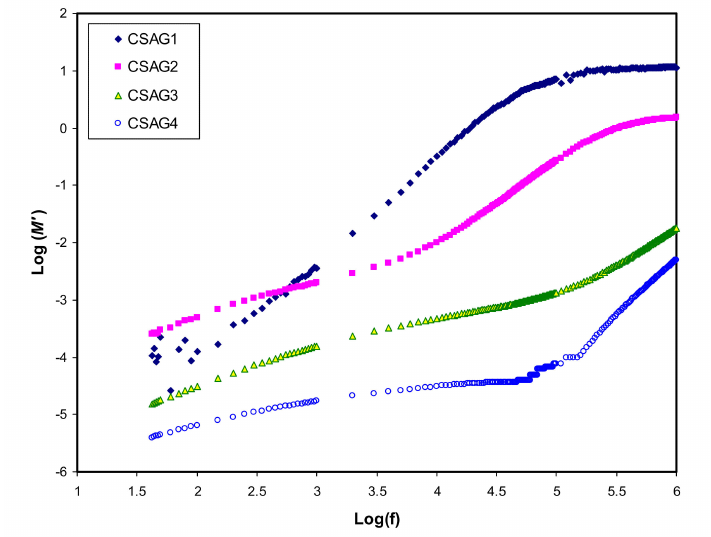
Figure 4. A real part of an electric modulus ( M ’) against frequency for CSAG1–CSAG4 electrolyte systems at room temperature.